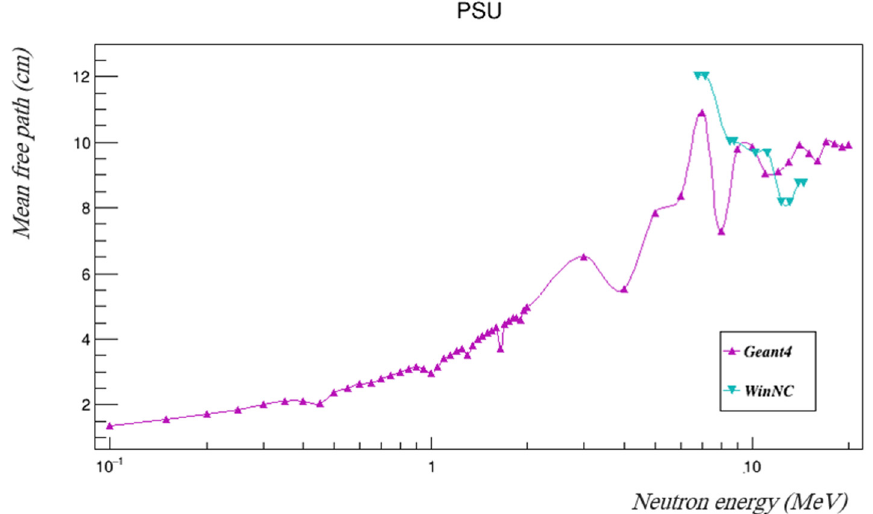
Figure 8. The neutron mean free paths of PSU at the investigated gamma energies using both Geant4